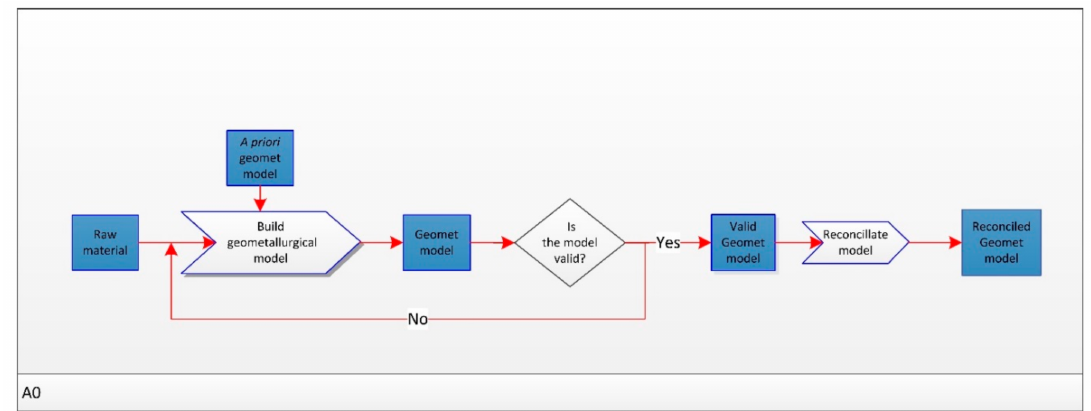
Figure 4. A child diagram of the Develop geometallurgical model function.